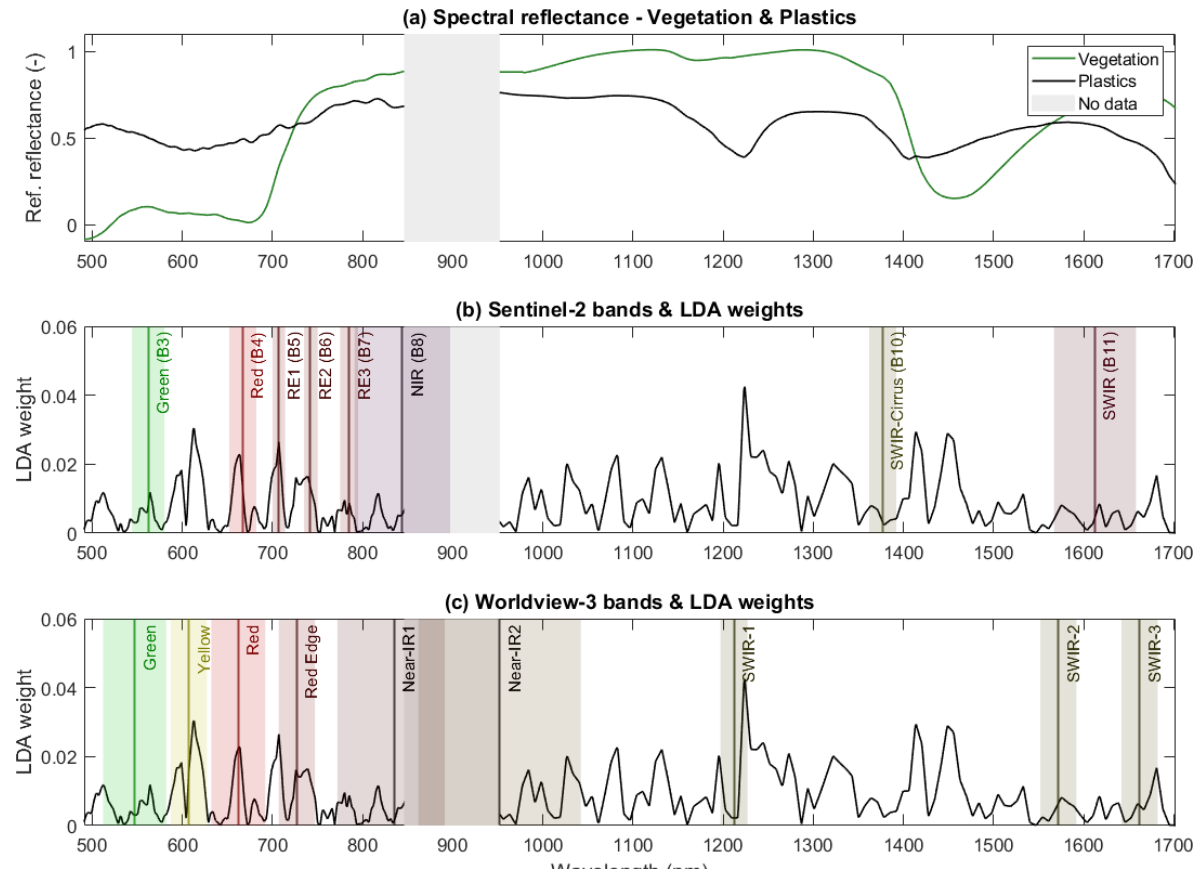
Figure 6. Reflection spectra of vegetation and plastics ( a ); weights of the LDA separating vegetation and plastic items overlaid with central wavelengths and bandwidths of the Sentinel-2 MSI ( b ); and overlaid with central wavelengths and bandwidths of Worldview-3 MS-VNIR and MS-SWIR ( c ).